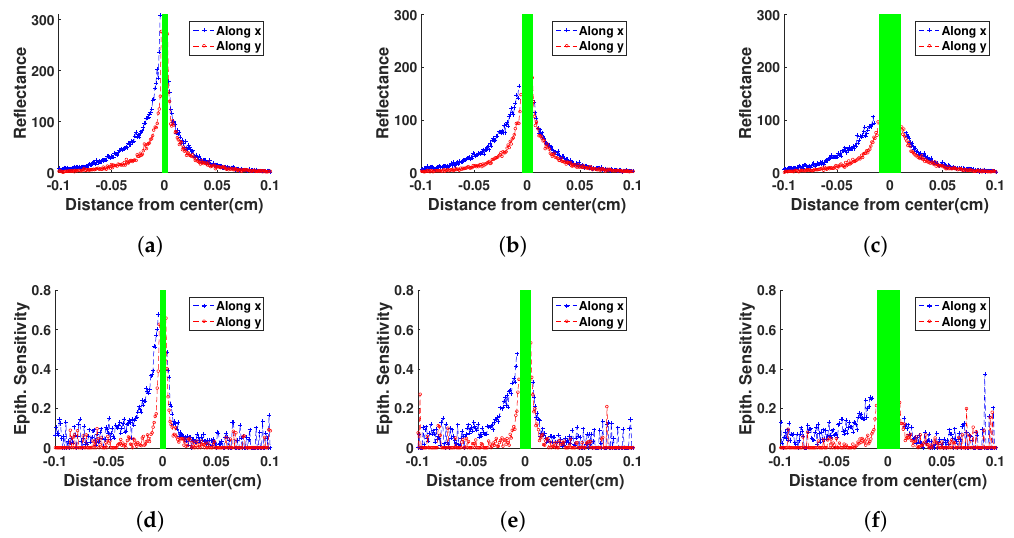
Figure 3. For probe geometry-II and bevel angle β = 45 ◦ , the collected SRR along x- and y- axes for source fiber diameters ( a ) 50 µ m, ( b ) 100 µ m, and ( c ) 200 µ m. Corresponding epithelial sensitivity plots for source fiber diameters ( d ) 50 µ m, ( e ) 100 µ m, and ( f ) 200 µ m. Width of the green region at the center of each of the plots indicates the size of the source (color online only).